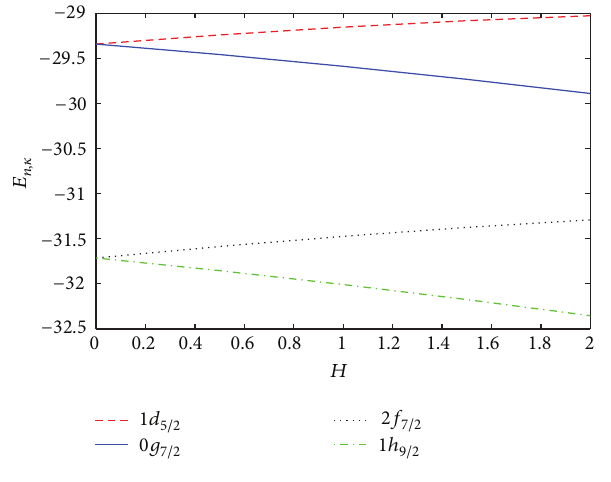
Figure 4: Effect of tensor potential on p -spin